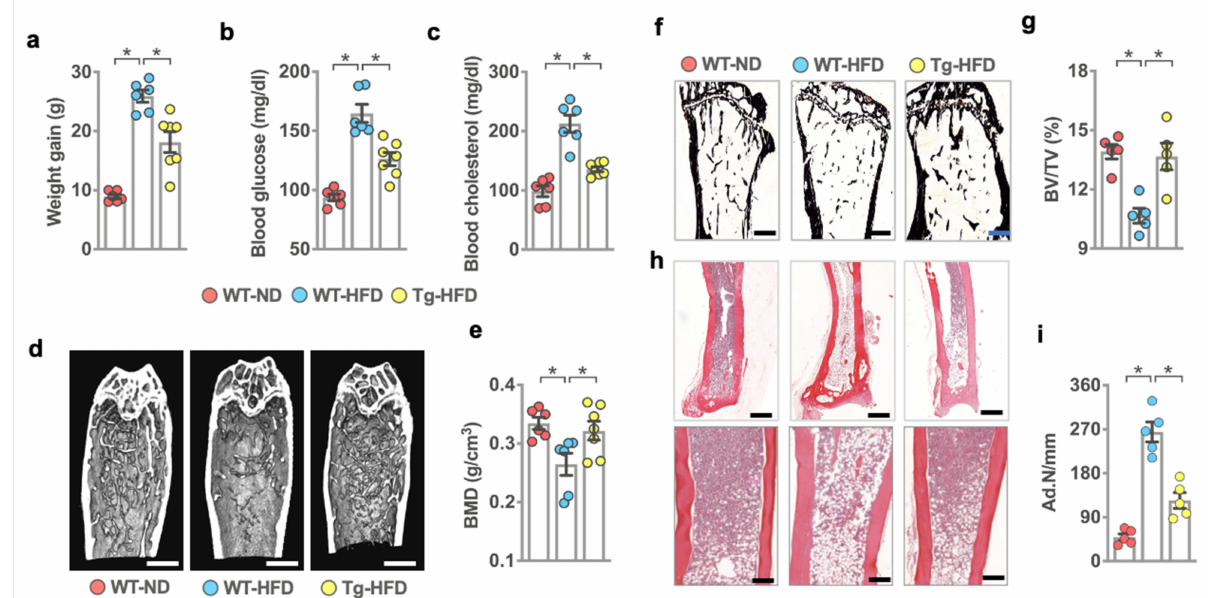
Figure 1. Analysis of serum biochemistry, bone mass, and histology of wild-type and miR-29aTg mice upon standard rodent chow (ND) and high-fat diet (HFD) feeding. HFD-mediated increases in body weight gain ( a ), serum cholesterol ( b ), and blood glucose levels ( c ) were compromised in miR-29aTg mice. Sagittal views of µ CT images showing scarce trabecular bone network in HFD-fed WT mice and dense bone microstructure in HFD-fed miR-29Tg mice ( d ); scale bar, 5 mm. miR-29a overexpression attenuated HFD-induced loss in bone mineral density ( e ). Investigations (mean ± S.E.) are calculated from 6–7 mice. miR-29a overexpression compromised HFD-mediated sparse trabecular morphology ( f ), BV/TV loss ( g ) (scale bar, 40 µ m), marrow adiposity ( h ) (scale bars, 100 µ m in higher panels and 40 µ m in lower panels), and Ad.N ( i ). Mean ± S.E. is calculated from 5 mice. * p < 0.05 upon ANOVA test and Bonferroni post hoc test. ND, standard rodent chow; HFD, high-fat